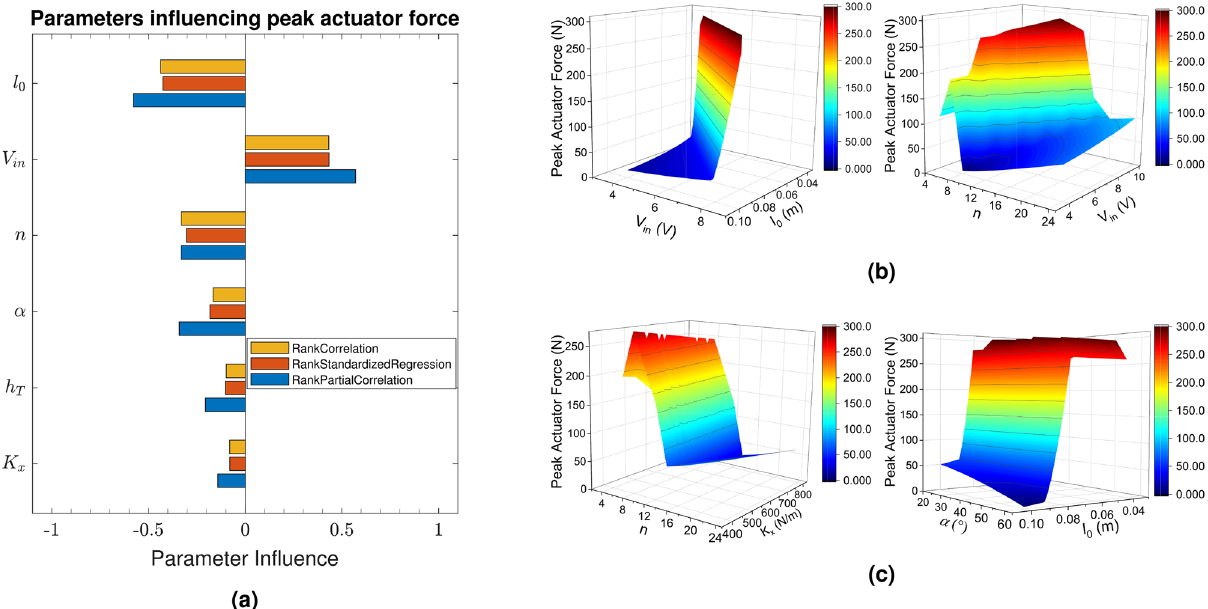
Figure 6. ( a ) The correlation coefficient values of the model parameters and their influence on the maximum output force for 2500 unique set for the mentioned model parameters are shown in a tornado plot. The graph depicts the rank correlation of several metrics. It is clear that V in is the sole positively correlated parameter, while l 0 is the most inversely correlated. The influence of various parameters in multiple combinations on the peak muscle force is depicted in ( b , c ). K x ranges from 400–800 N/m, while n ranges from 4 to 24. Voltage ( V in ) has been altered from 4 to 10 V, wire length ( l 0 ) has been varied from 40–100 mm and pennation angle ( α ) has been varied from 20 − 60 ◦